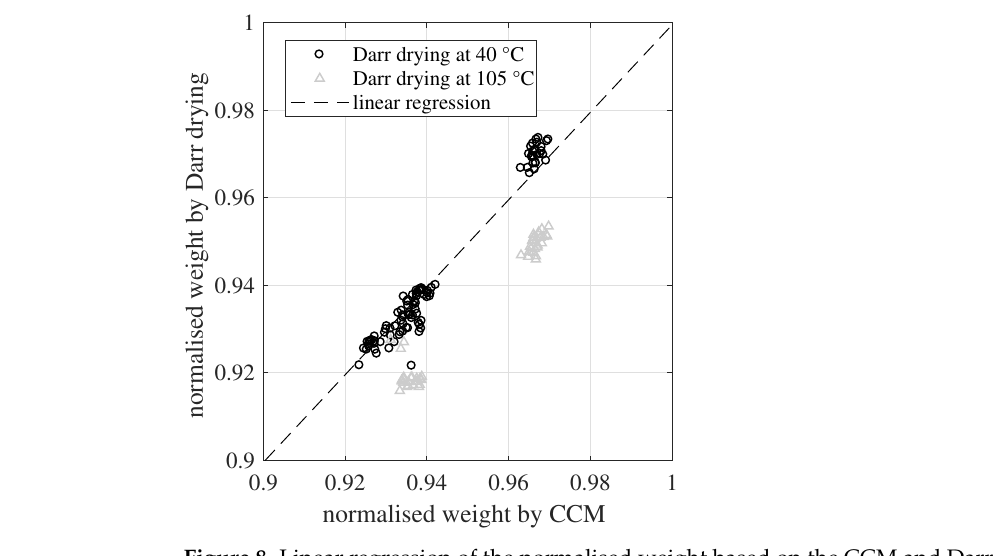
Figure 8. Linear regression of the normalised weight based on the CCM and Darr drying (at 40 °C). The regression comprises only a slope coefficient, excluding a y-axis